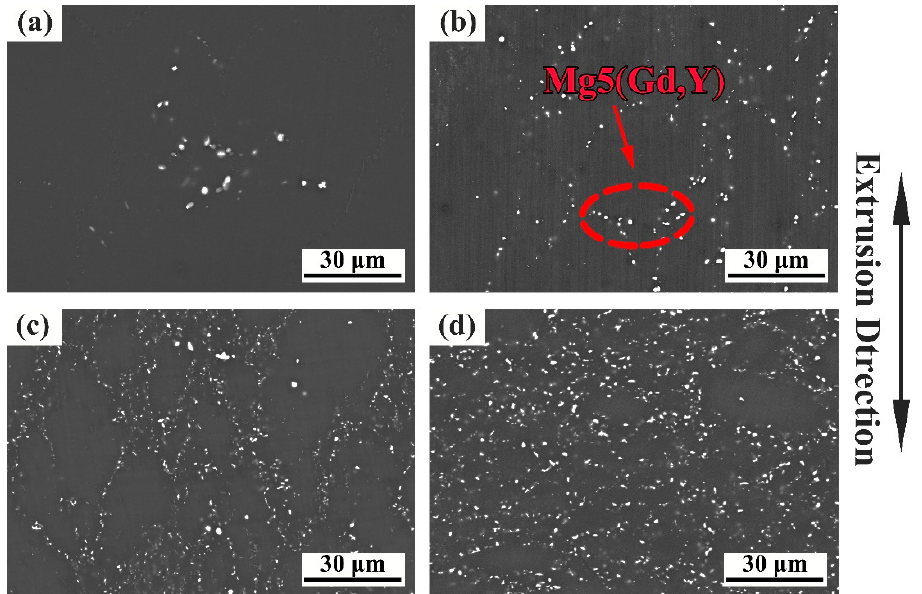
Figure 4. The back-scattered electron (BSE) of the samples RUEed after different passes. ( a ) 1 pass; ( b ) 2 passes; ( c ) 3 passes; ( d ) 4 passes.